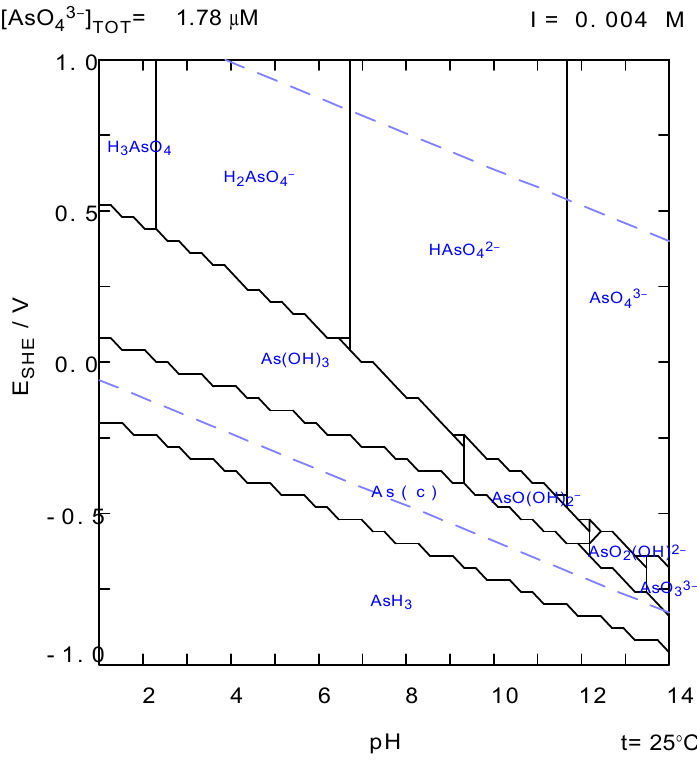
Figure 2. Eh-pH diagram for predominant arsenic species in equilibrium in raw water from Well No. 1 (Initial 0.134 mg As·L − 1 ; pH 6.61, Eh 0.16 V) at 25 °C and 1 atm.